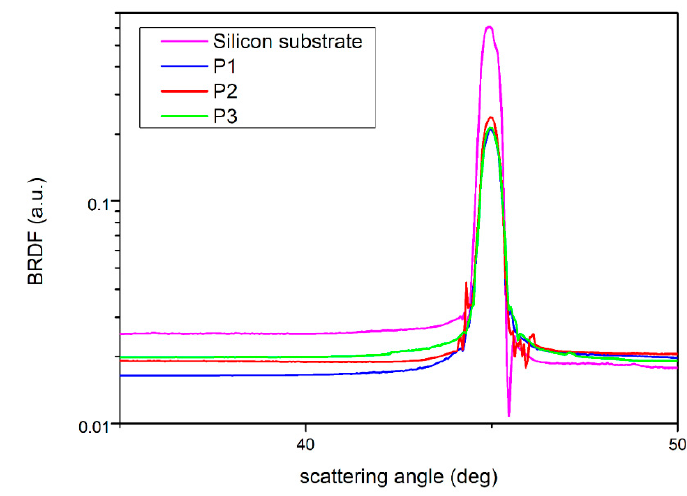
Figure 10. Normalised Bidirectional Reflectance Distribution Function (BRDF) for porous films and flat silicon substrate.